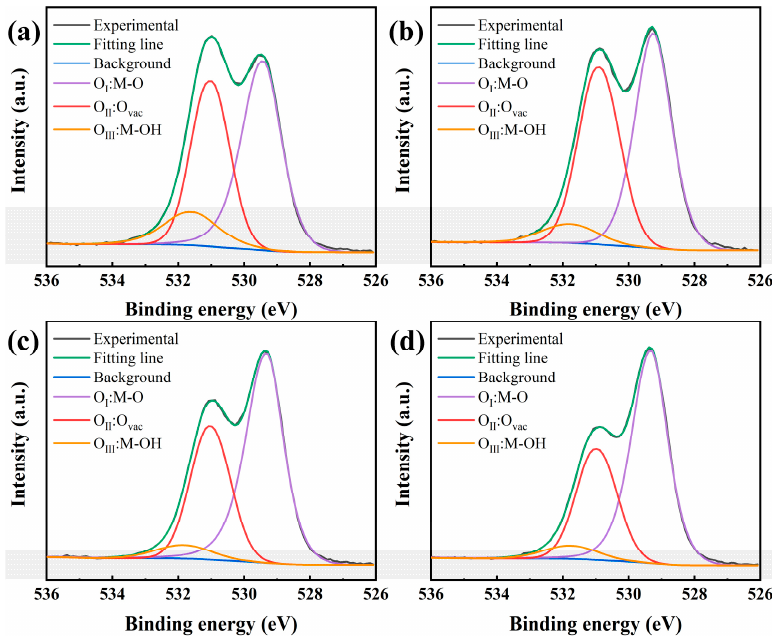
Figure 4. XPS O 1s of InTiO thin films with various composition ratios of ( a ) 20:1, ( b ) 18:1, ( c ) 15:1, and ( d ) 10:1.